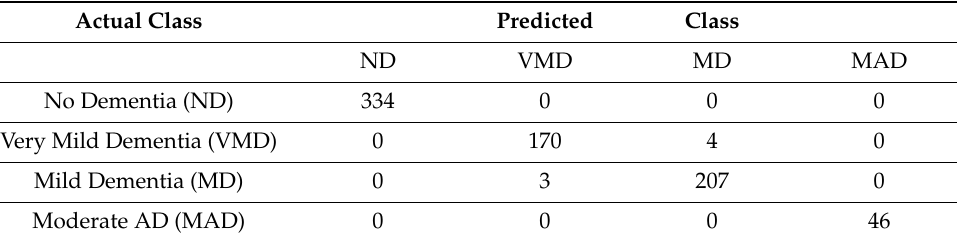
Table 4. Proposed model confusion matrix on the OASIS data.